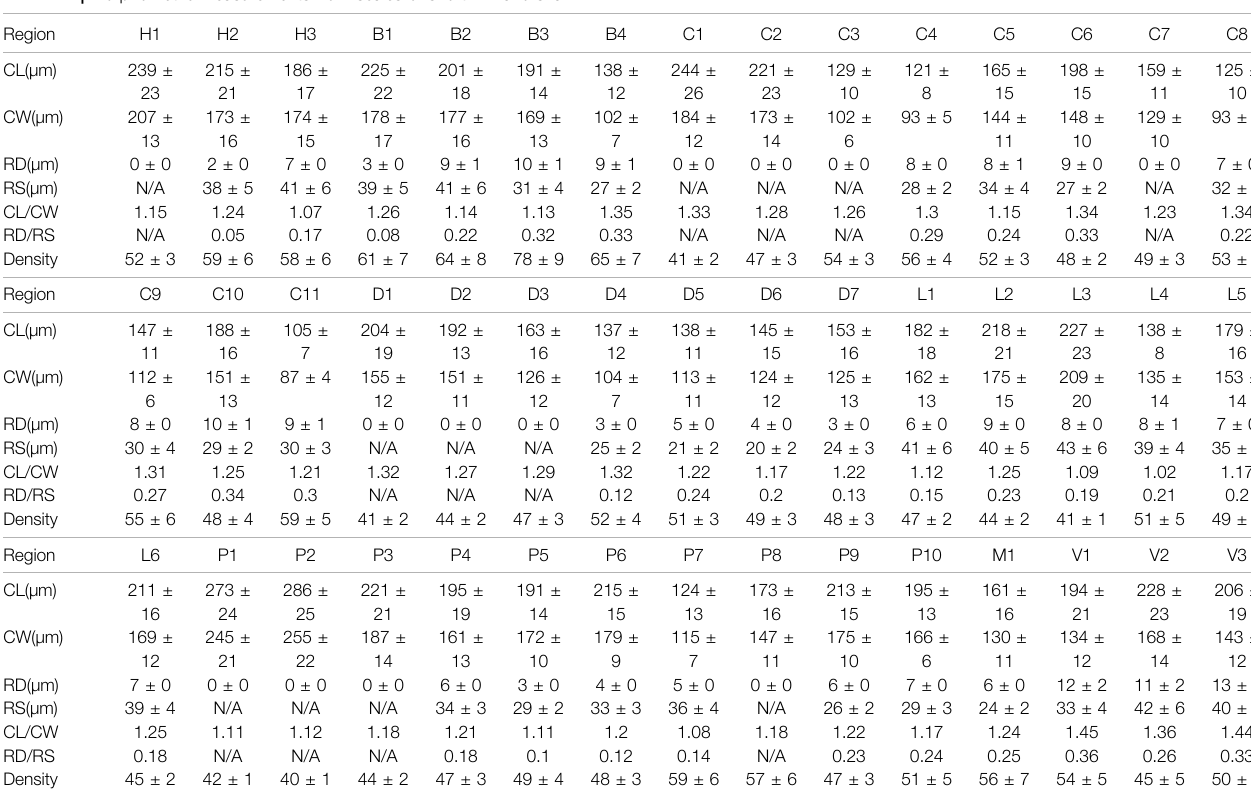
TABLE 2 | Morphometric measurements from scales of short fi n mako shark.